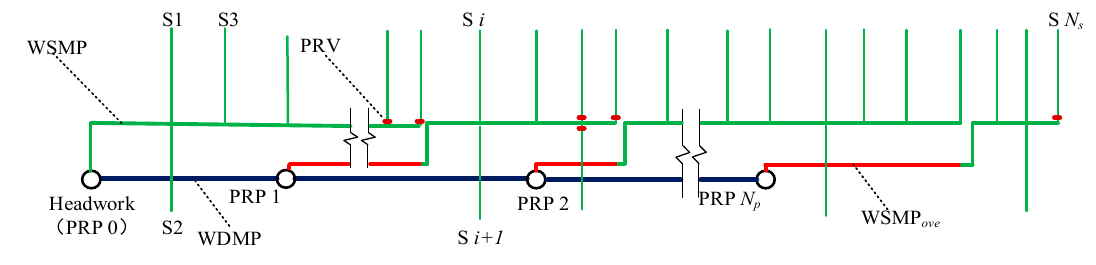
Figure 1. Schematic of a G-MPS.